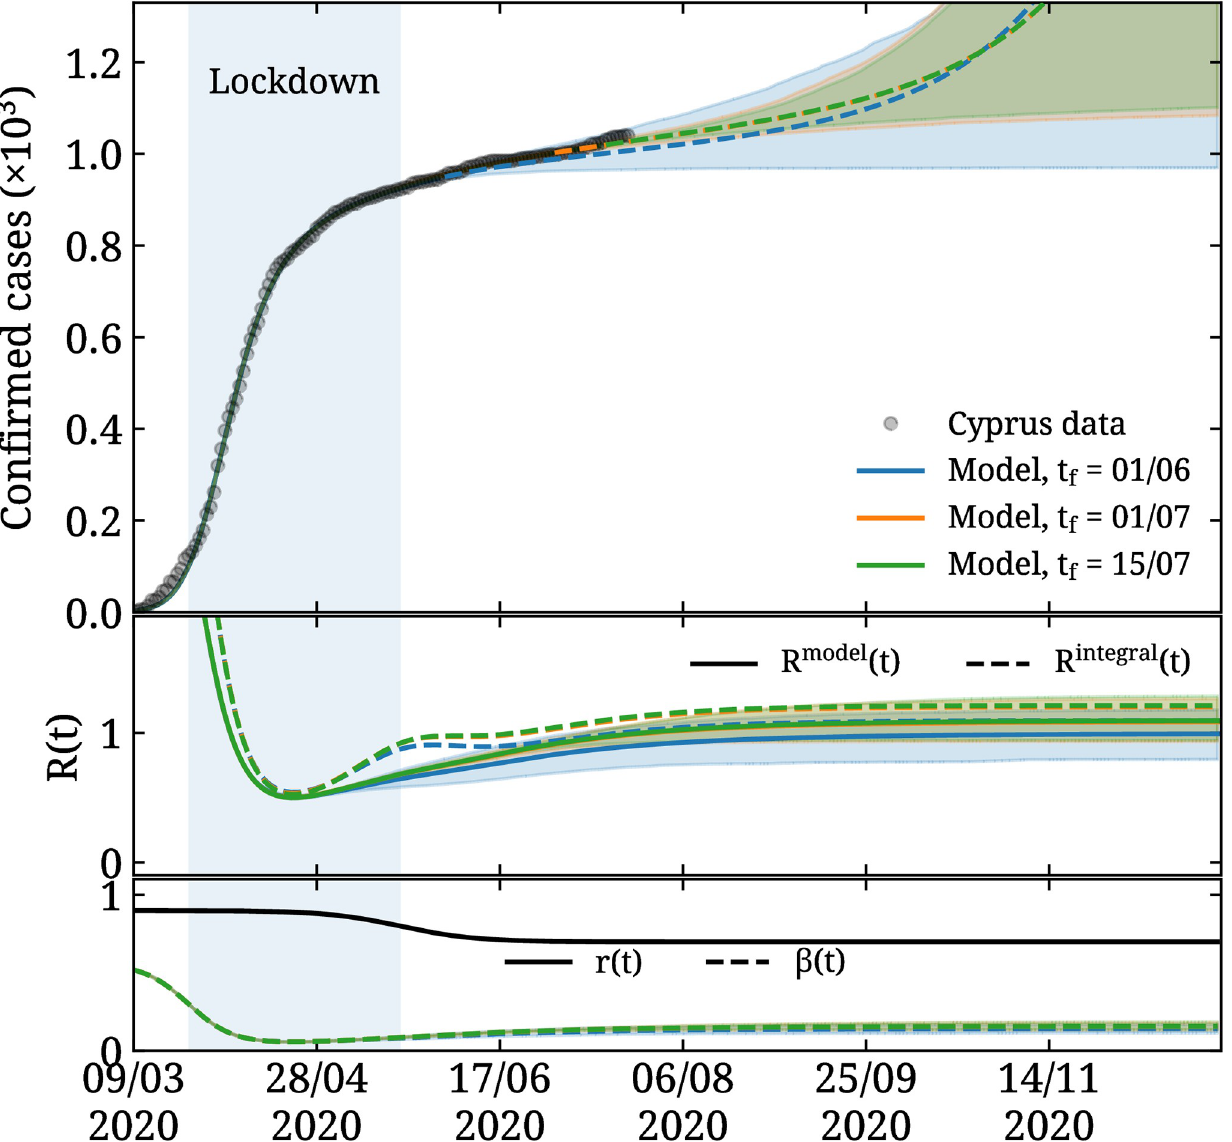
Fig 3. Fitting the SEIQR model. In the top panel, we show the reported cases in Cyprus (circles) as a function of time and the result of fitting our SEIQR model. We consider three periods taking t f = 84 (blue curve), 114 (orange curve), and 128 (green curve) that overlap with the data. The blue shaded region shows the interval between March 25 th and May 21 st , used as t 1 and t 2 in Eq (7). The dashed curves and bands show the predicted mean value and 90% confidence level as the time range being fitted varies by changing t f . The central panel shows R model with the solid curves and R integral with the dashed curves. The bottom panel shows the ratio of undetected r ( t